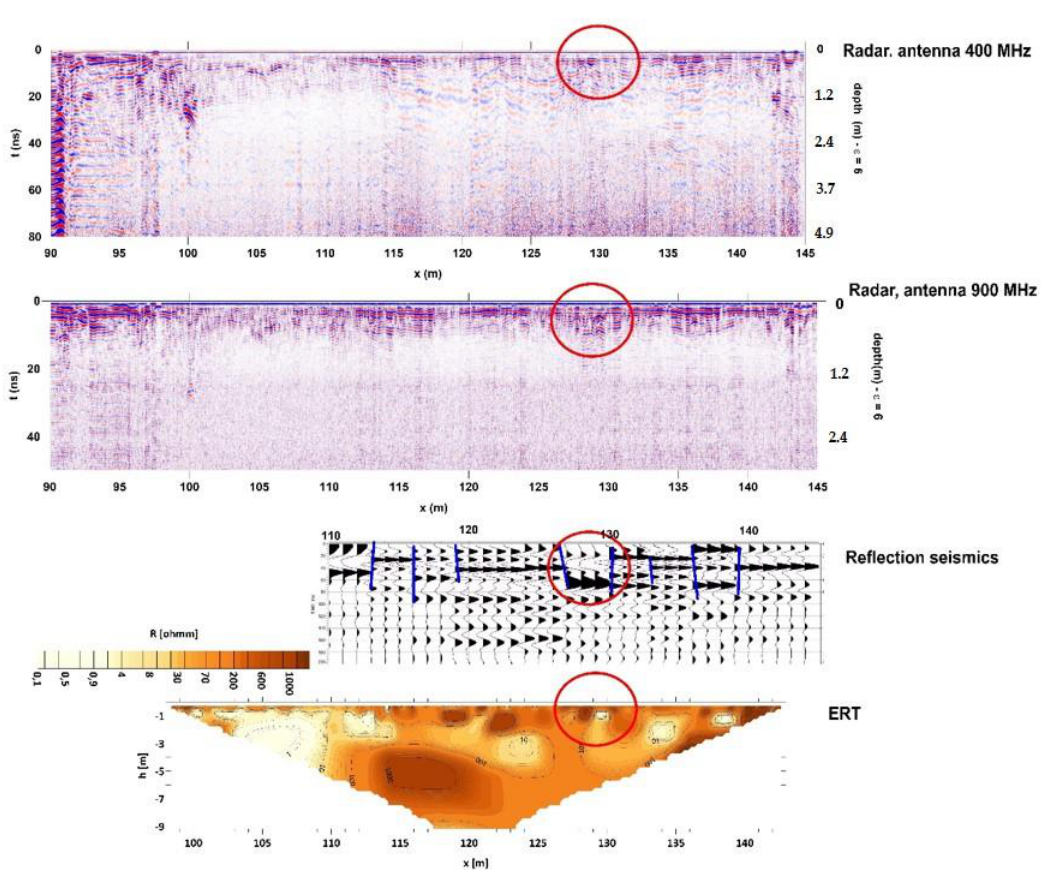
Figure 26. Lesser Town Square. Summary of geophysical methods—ERT, seismic reflection and radar on the profile P155.